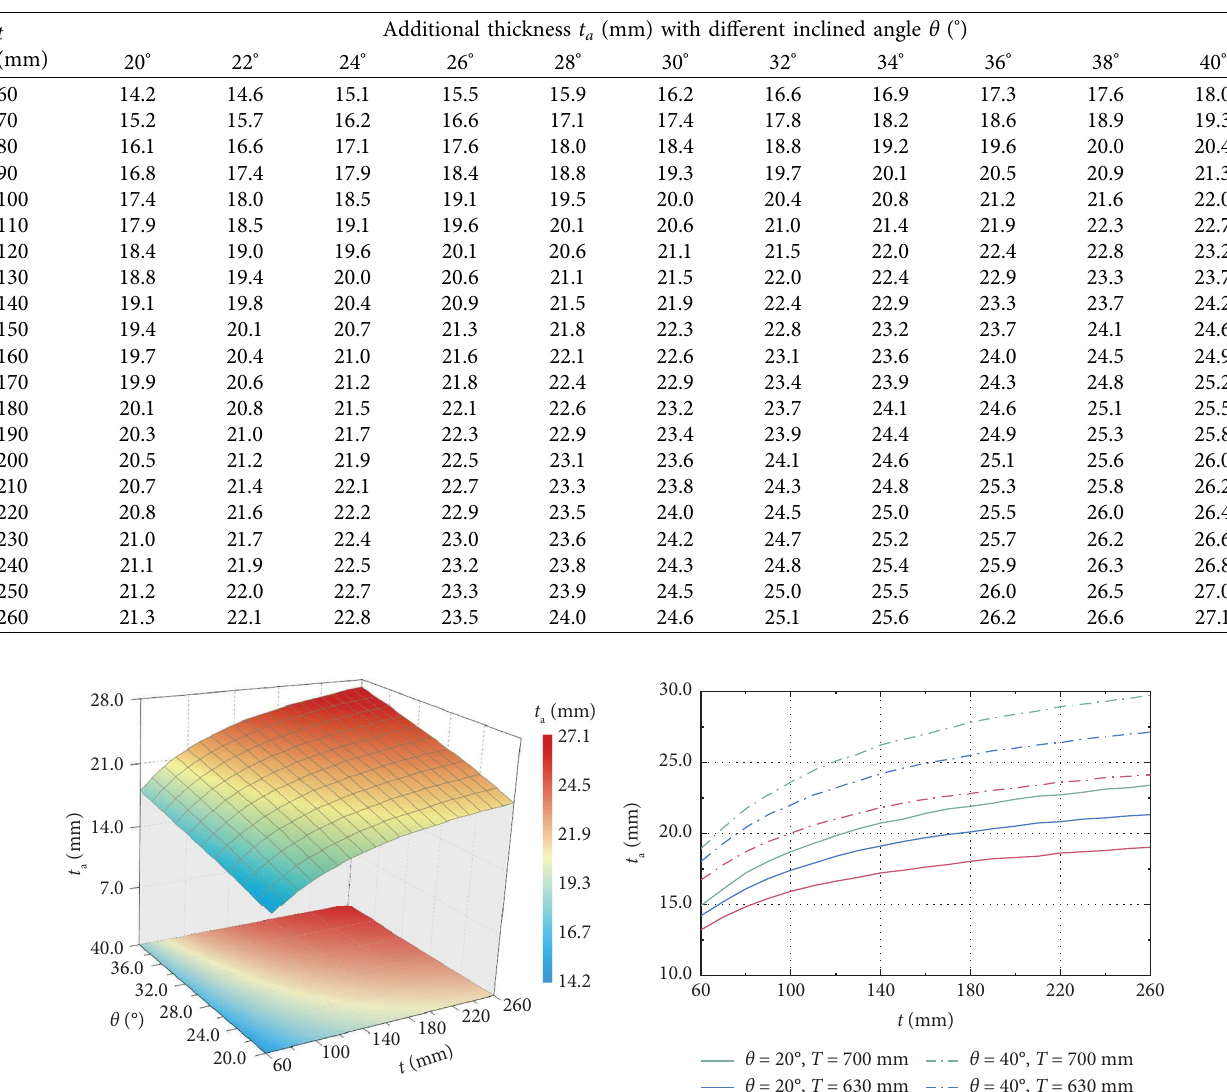
Table 1: Summary of t a with diferent θ and t when T is